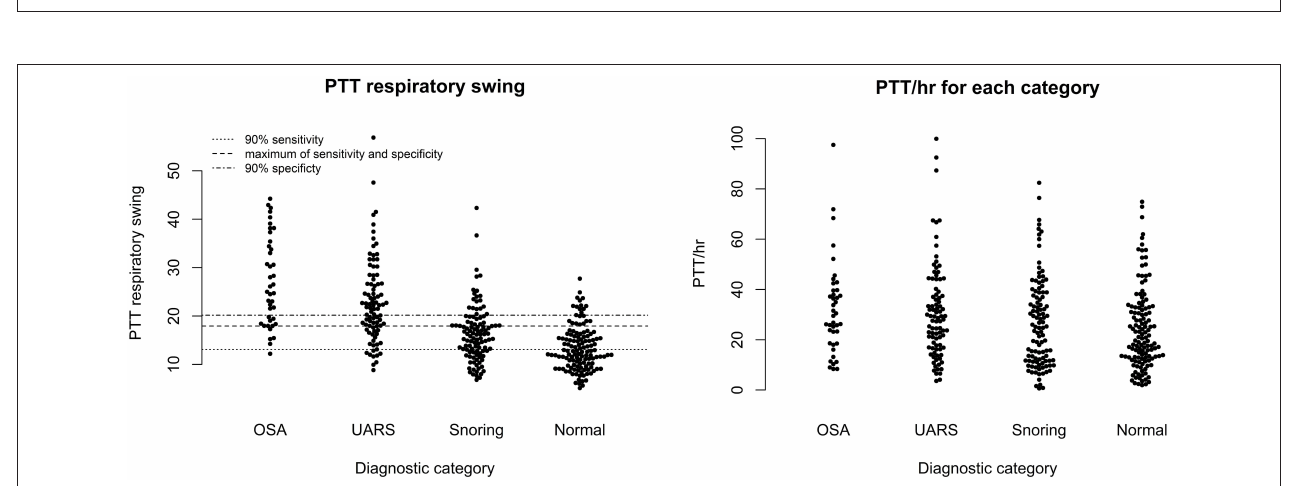
FIGURE 6 | Scatter plots of PTT respiratory swing and PTT arousal index.